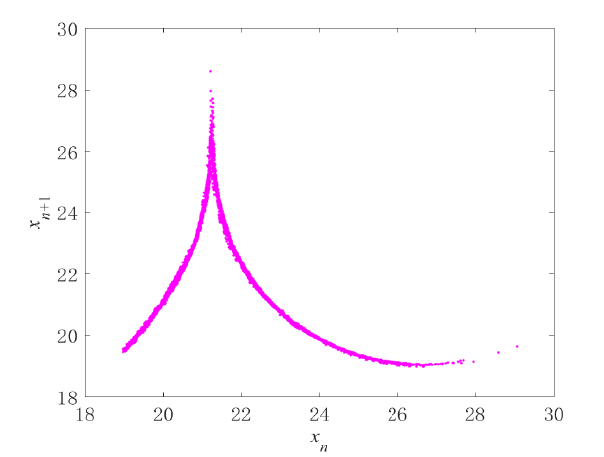
Figure 12. First return map of system (2) under parameters ( a , b , c , d ) = ( 35,3,35,10 ) ; the Poincaré section is taken as z = 35.